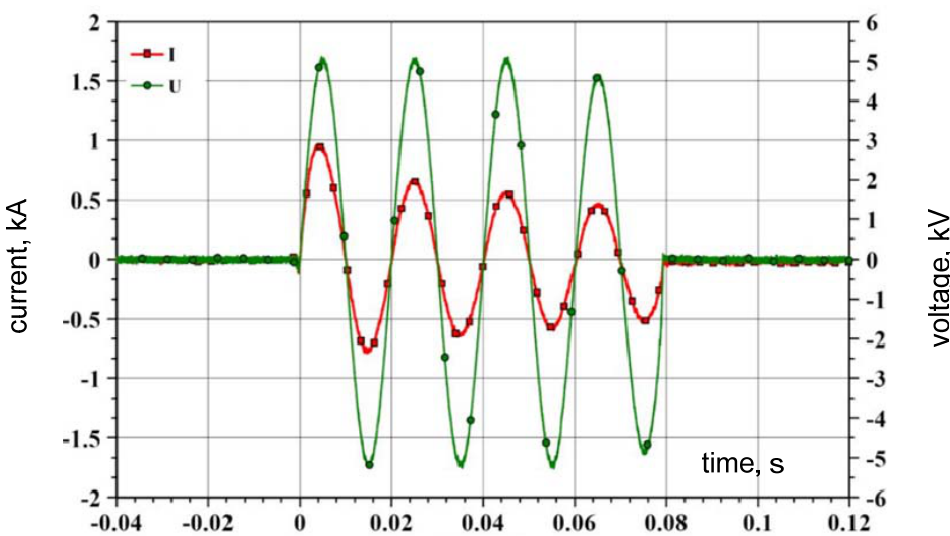
Figure 6. The course of the short-circuit current and the measured voltage at the limiter—short-circuit test No. 3. ( T 0 = 86 K). I—current, U—voltage.